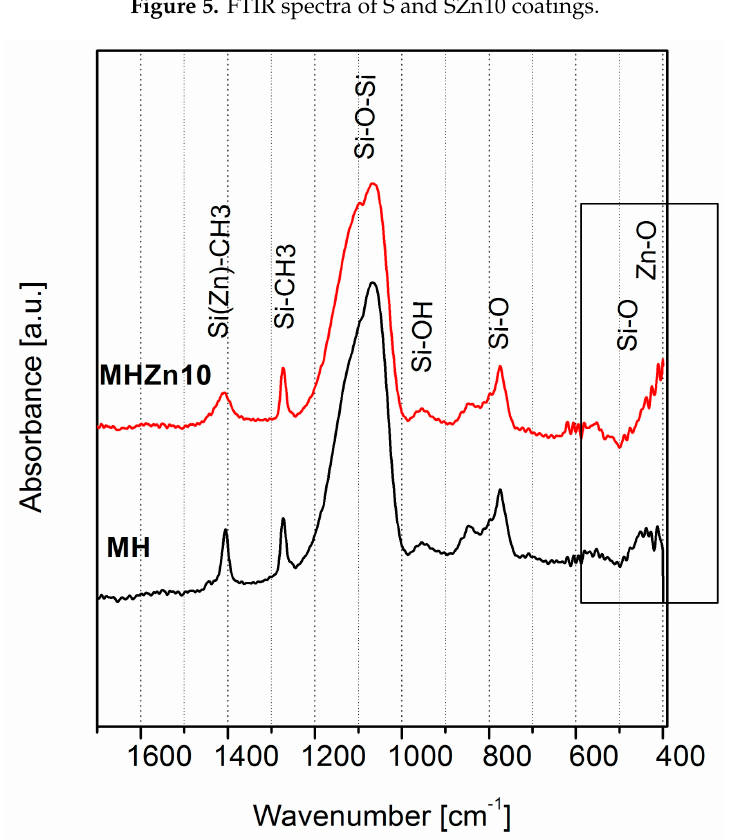
Figure 6. FTIR spectra of MH and MHZn10 coatings.